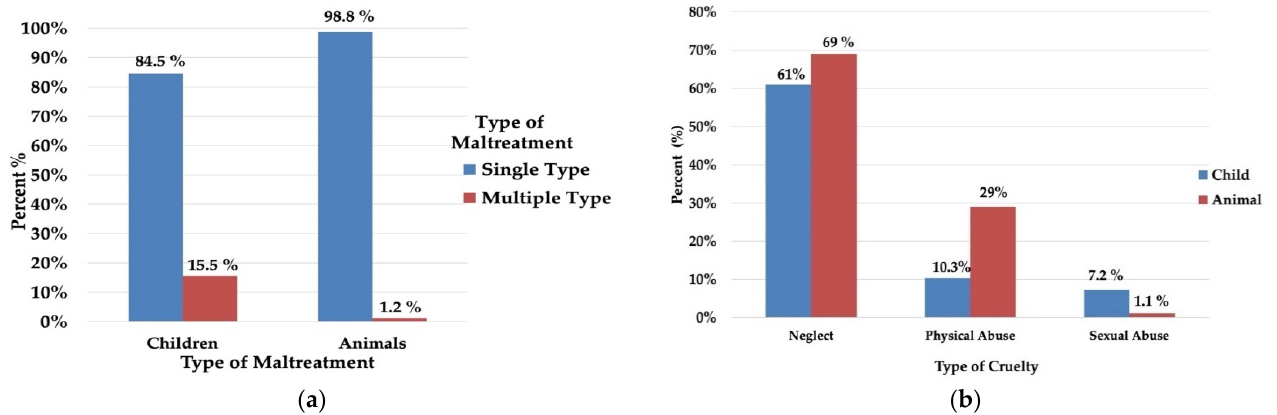
Figure 12. ( a ) Comparison of Child Maltreatment and Animal Cruelty; ( b ) Comparison of Child Maltreatment and Animal Cruelty.